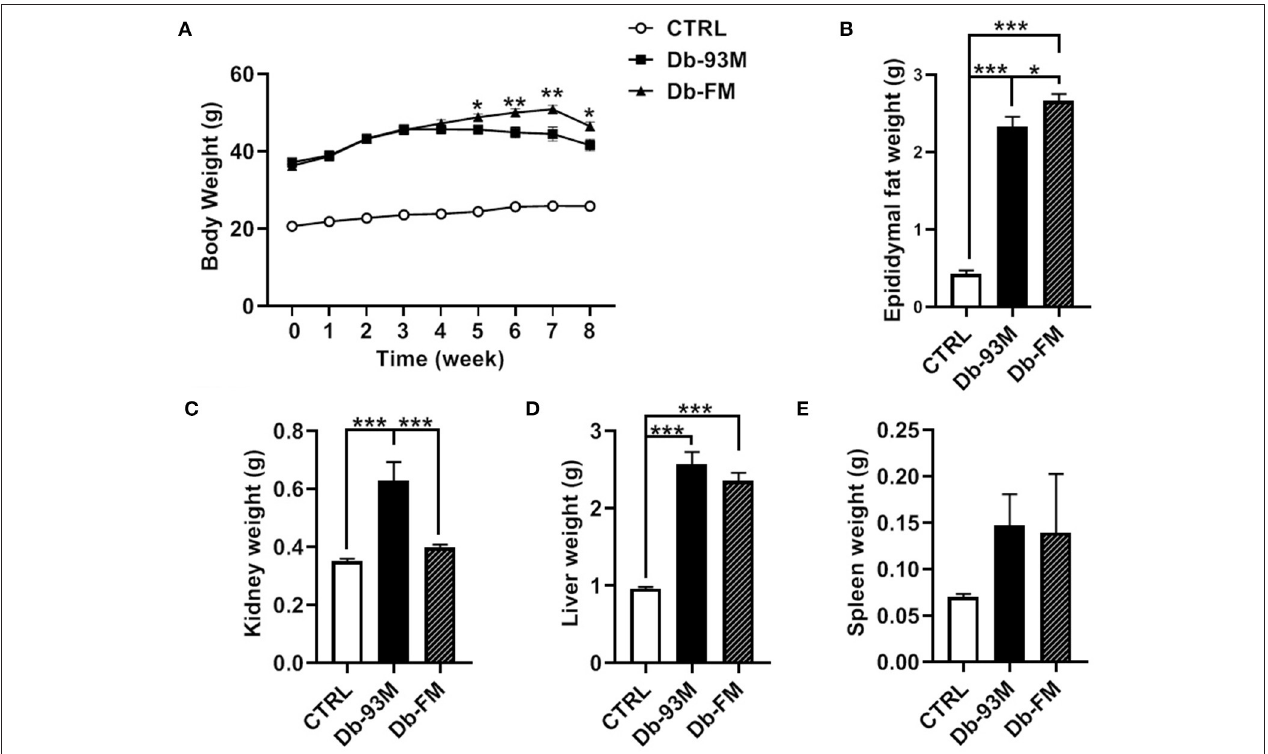
FIGURE 1 | Physiological parameters. (A) Body weight changes during 8 weeks on diets, asterisks indicate significant differences between the Db-93M group and the Db-FM group (* p < 0.05, ** p < 0.01). (B) Epididymal fat weights comparison. (C) Kidney weights comparison. (D) Liver weights comparison. (E) Spleen weights comparison. Data are expressed as the mean ±